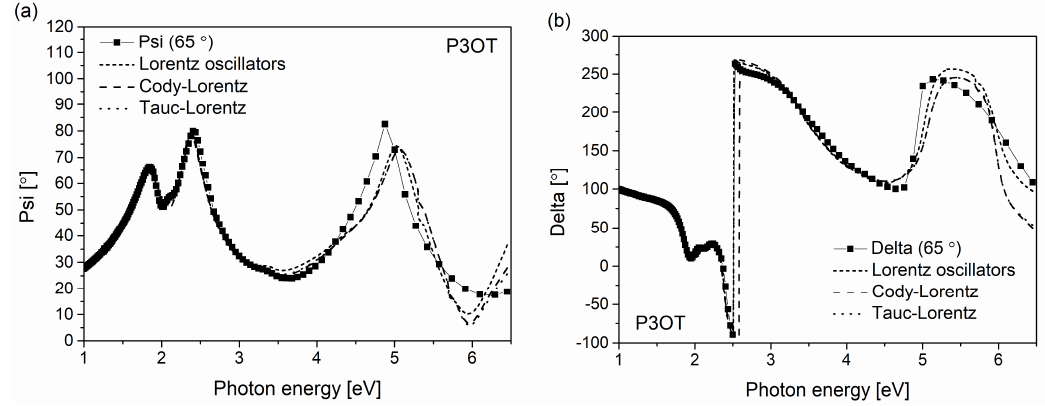
Figure 7. Spectra of P3OT ellipsometric angles ( a ) Psi, ( b ) Delta.